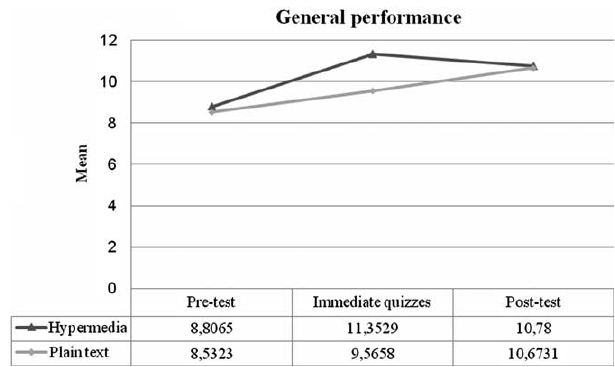
Figure 1. Learners’ vocabulary retention in hypermedia and plain text